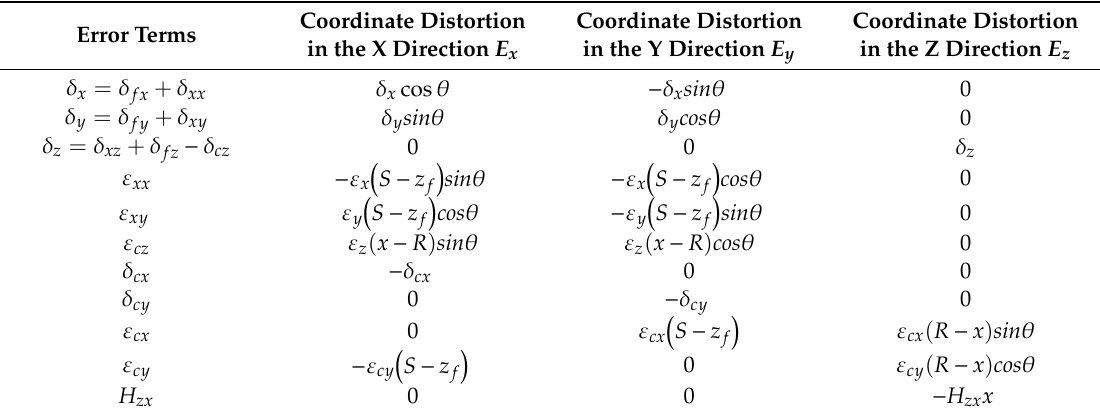
Table 2. The simplified model of the machining